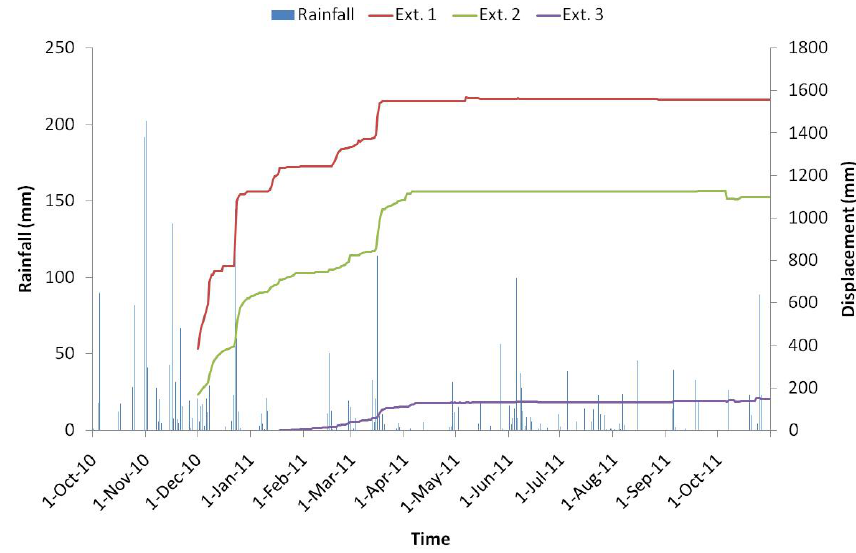
Fig. 9. Daily rainfall and displacements recorded by extensometers placed in the crown area after the November 2010 landslide event. Figure 10